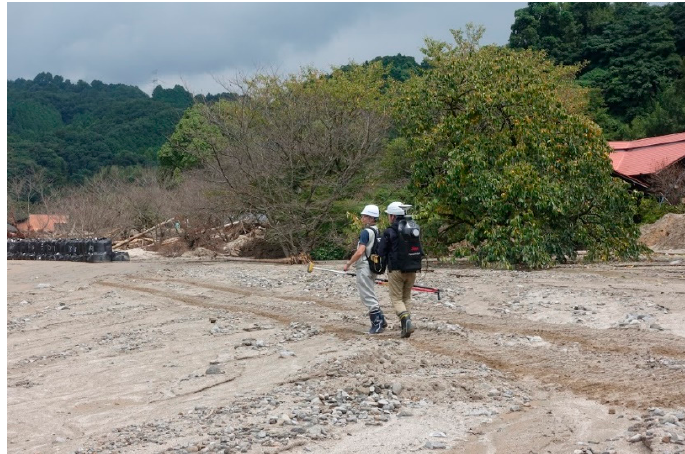
Figure 5. Field survey using PB (September 12, 2017: Photograph by Mr. Yoshiaki Ishida).